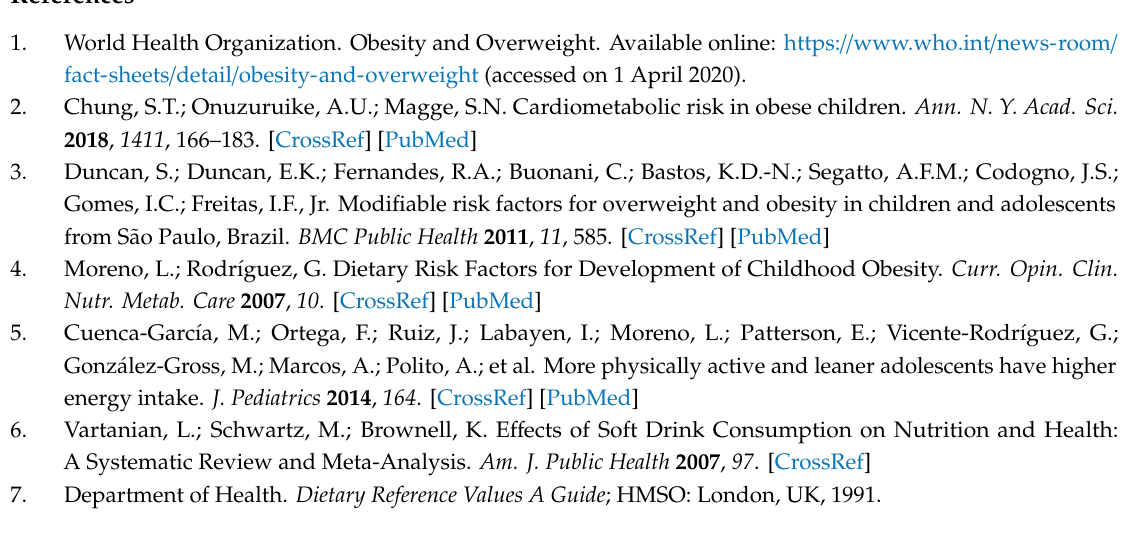
Table S1 Mean daily intake in grams (and standard deviation) for free sugars consumers from various dietary sources, compared by gender using the student-t test. Table S2 Frequency of consumption of food groups containing free sugars consumed as snack, according to BMI categories and